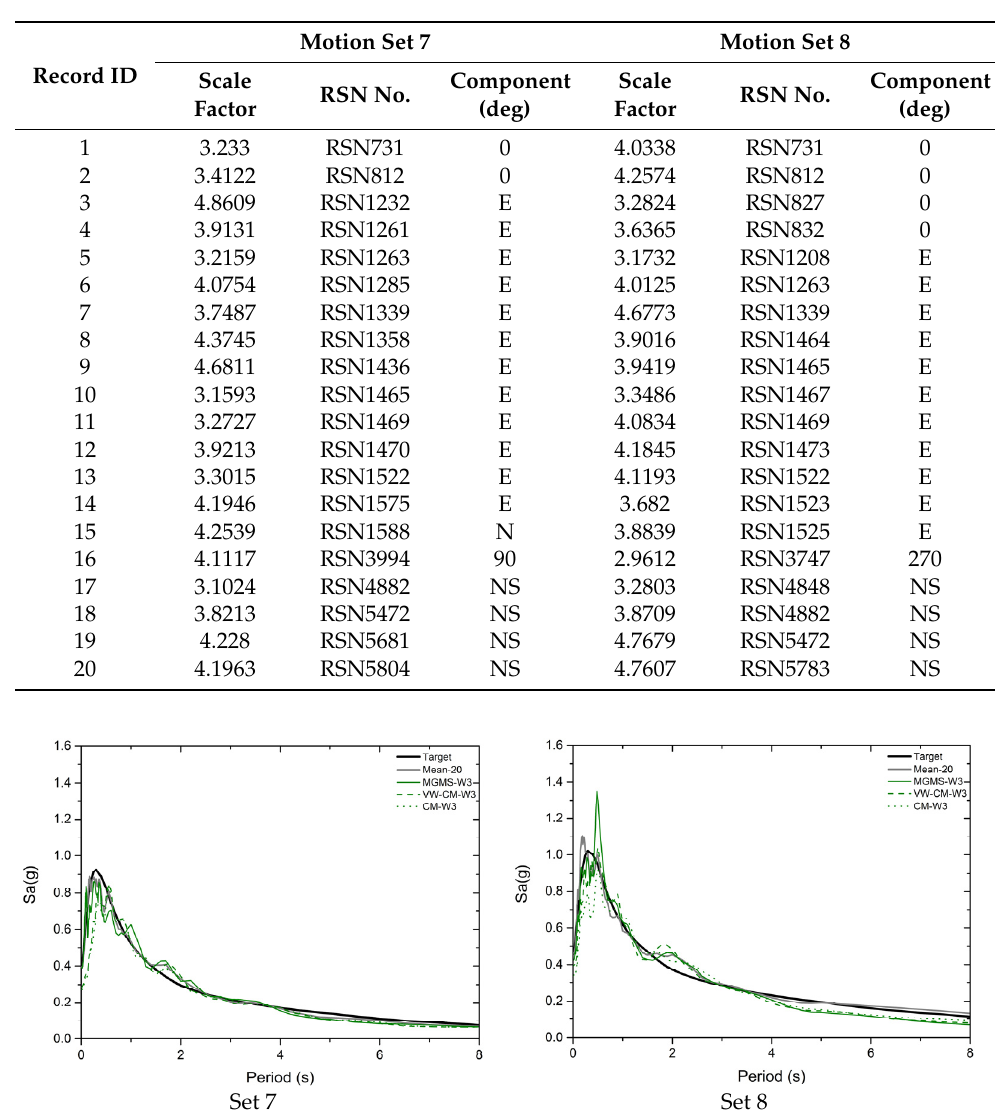
Figure A5. Mean spectra of IGMs selected from motion sets 5 and 6 with different selection procedures. Table A4. Details of IGMs of motion sets 7 and 8.